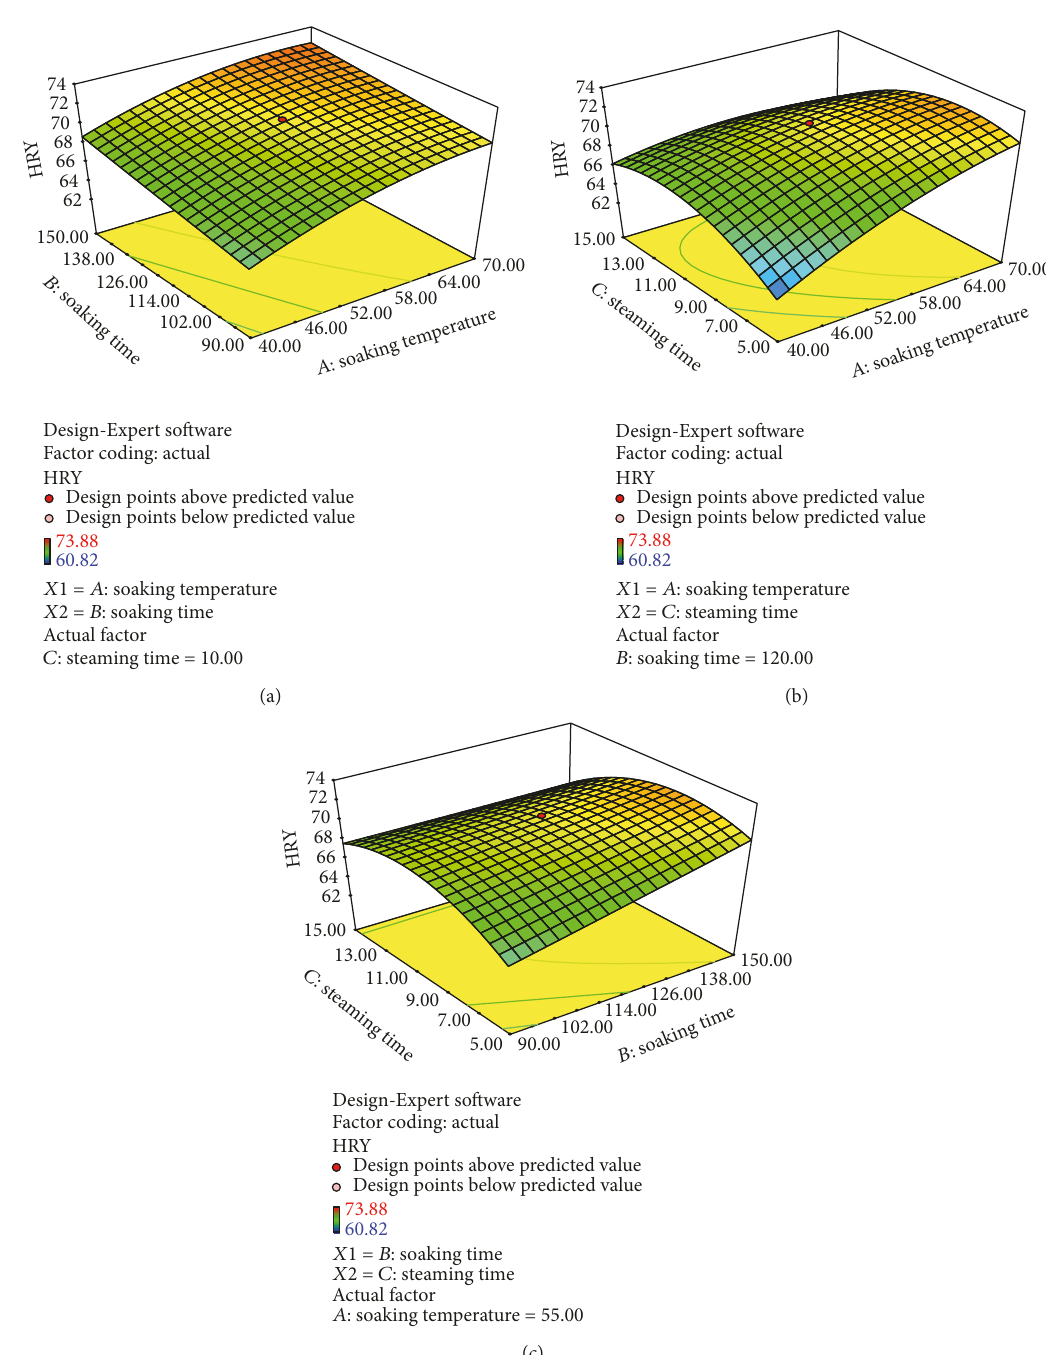
Figure 2: Effect of soaking temperature, soaking time, and steaming time on percentage